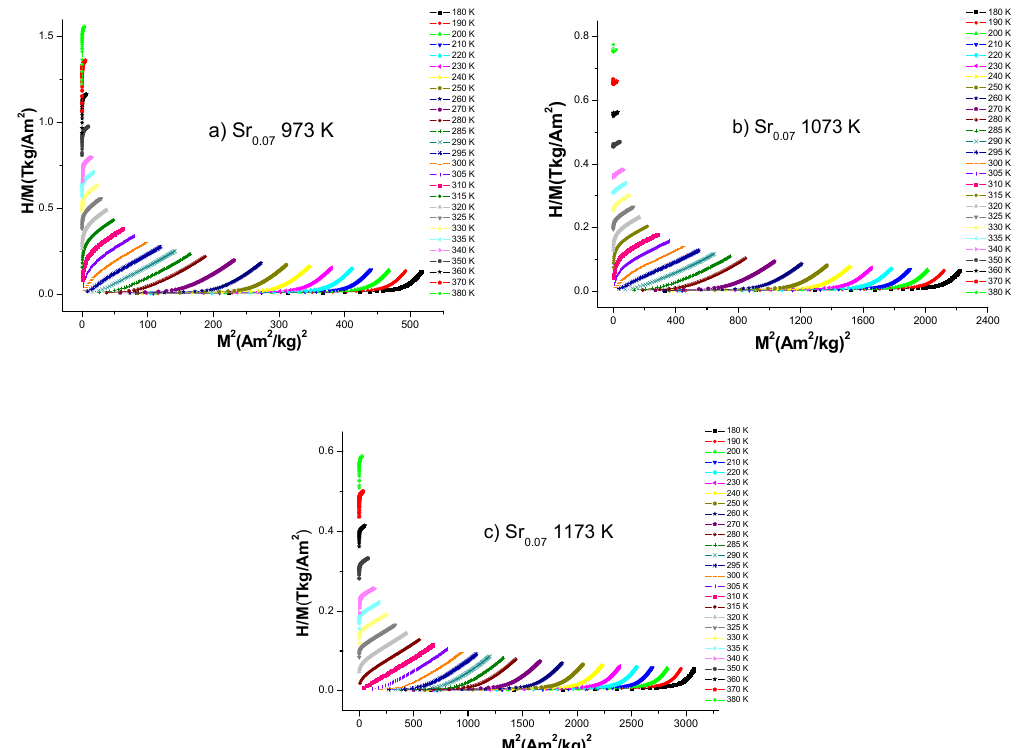
Figure 6. The Arrot plots for all La 0.7 Ca 0.23 Sr 0.07 MnO 3 nanofibers subjected to thermal treatment of ( a ) 973 K, ( b ) 1073 K and ( c ) 1173 K, respectively. It was possible to observe a positive value on the slopes corresponding to a second order magnetic phase transition.